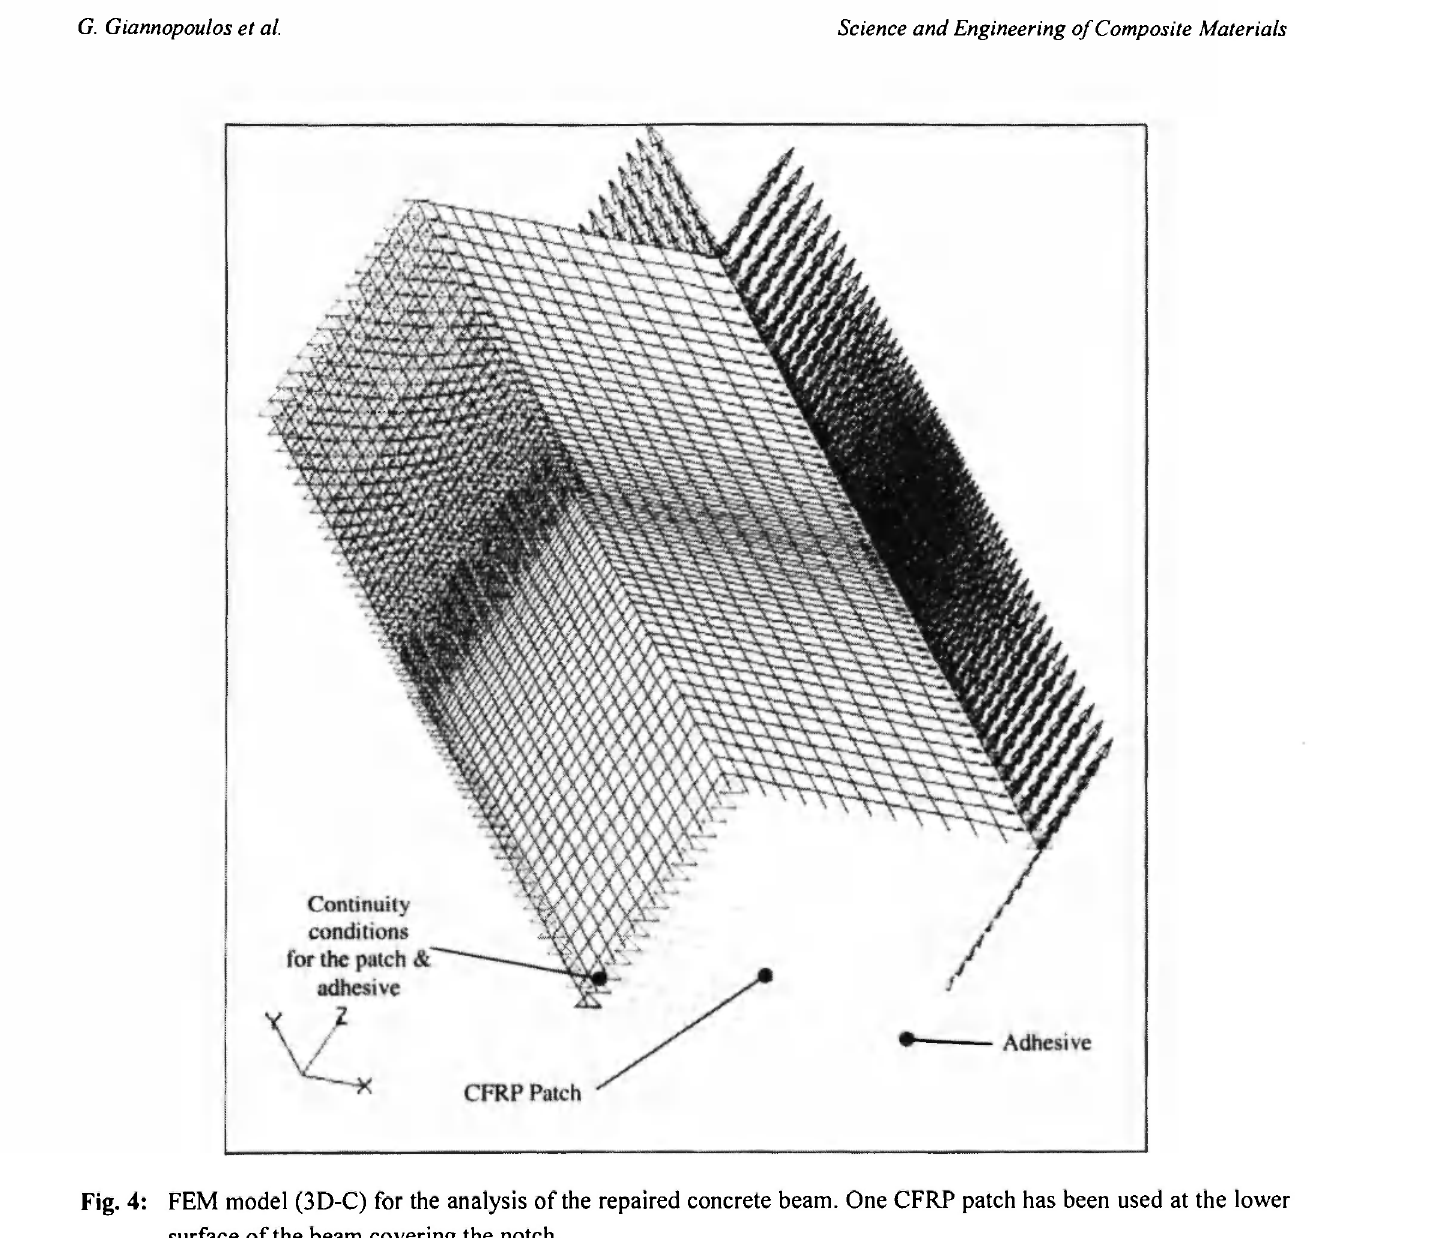
Fig. 4: FEM model (3D-C) for the analysis of the repaired concrete beam. One CFRP patch has been used at the lower surface of the beam covering the